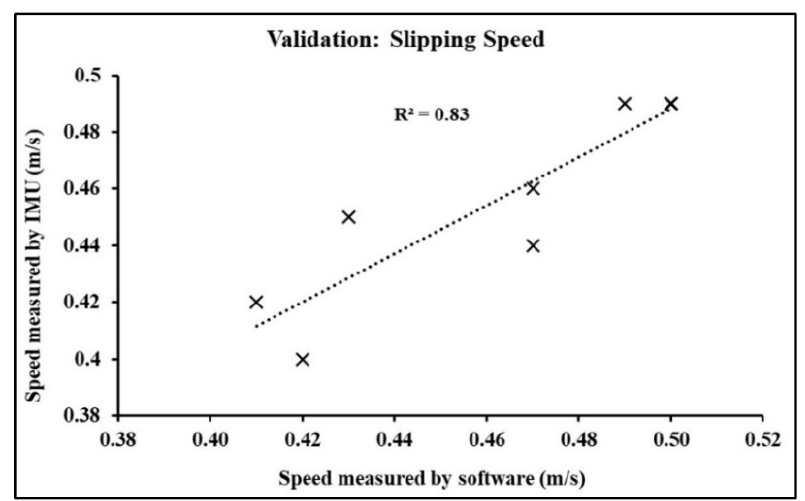
Figure 5. Variations in normal load.